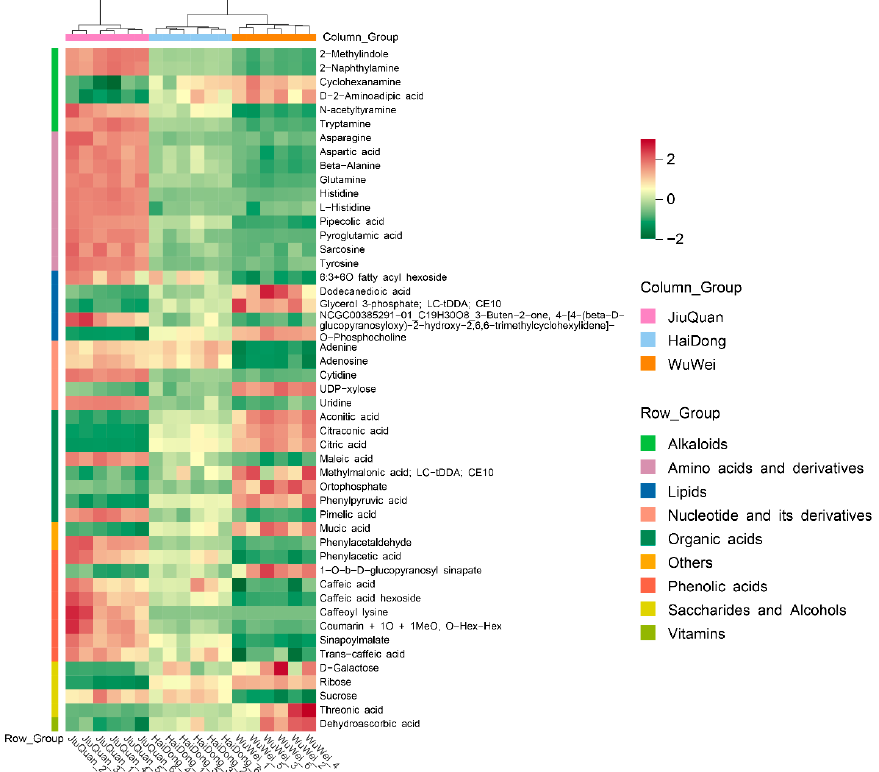
Figure 5. Clustering heat map of the top 50 differential metabolites.